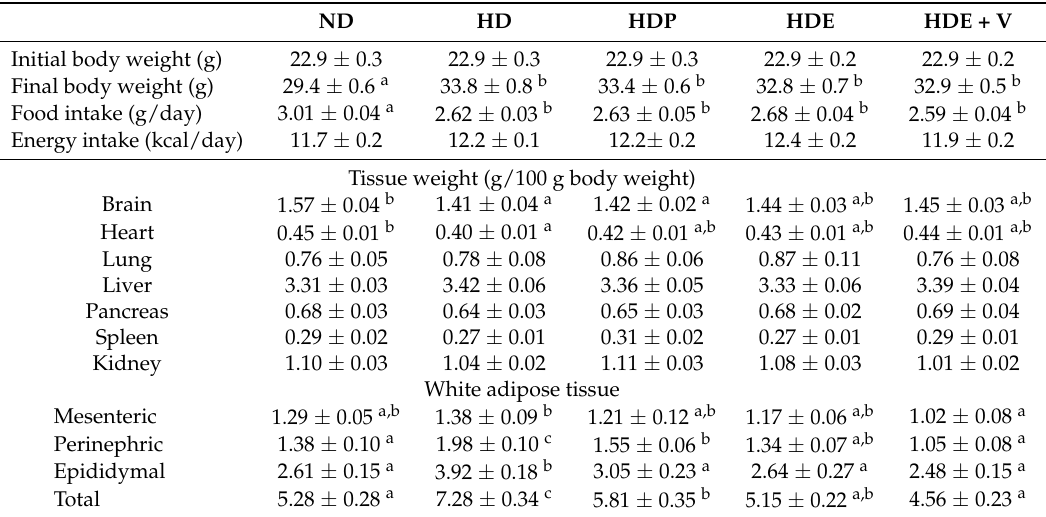
Table 3. Body weights, food intake and tissue